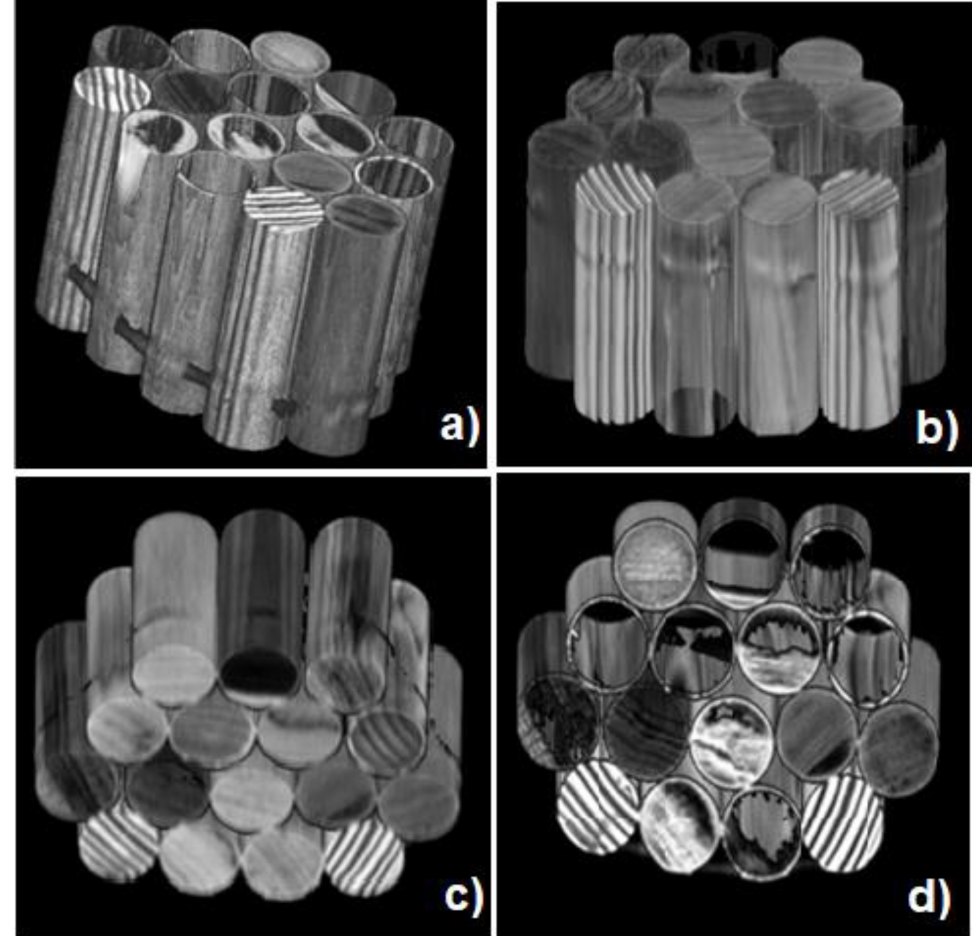
Figure 8. 3D surface rendering MRI obtained through the Render option of the MRIcro software, of a sample composed of sixteen different water-imbibed wood species (see Table 1 and Figure 2). Brighter zones represent wood structures of high-water content. Using the view projection of the option Render we can observe the sample at different orientations in space. The render option allows a change of the air/surface threshold and the surface depth to visualize 3D images with image contrast differences: ( a ) Image with minimum surface/depth values; ( b ) image with high air/surface values; ( c , d ) different values of the sharpness filter allow observations inside the wood samples. The mean cross-section diameter of wood samples is 2.95 ± 0.05 cm, and it is 20.0 ± 0.1 cm